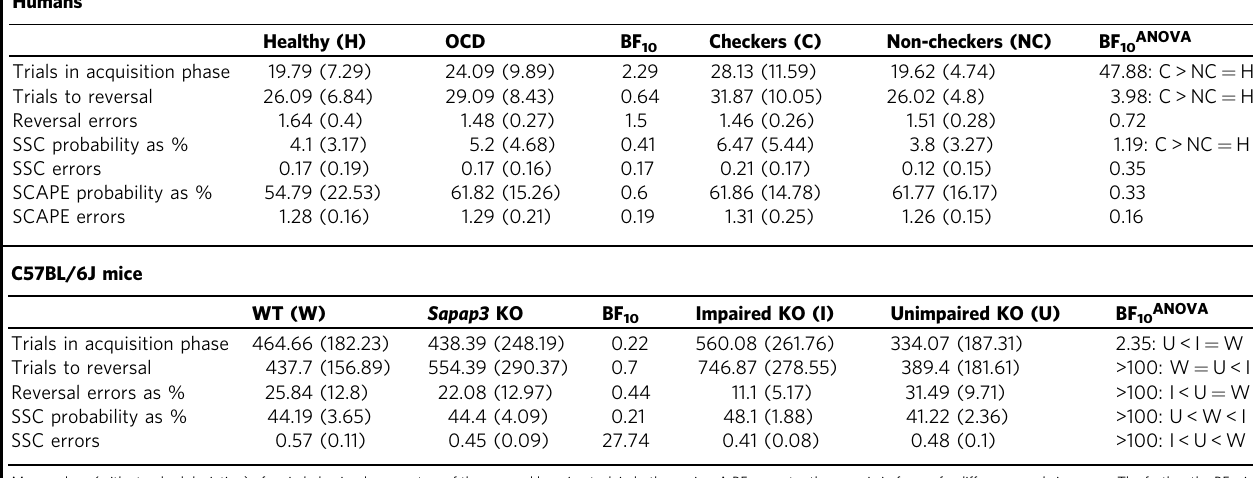
Table 1 Humans and mice behavioral parameters in the reversal learning task.